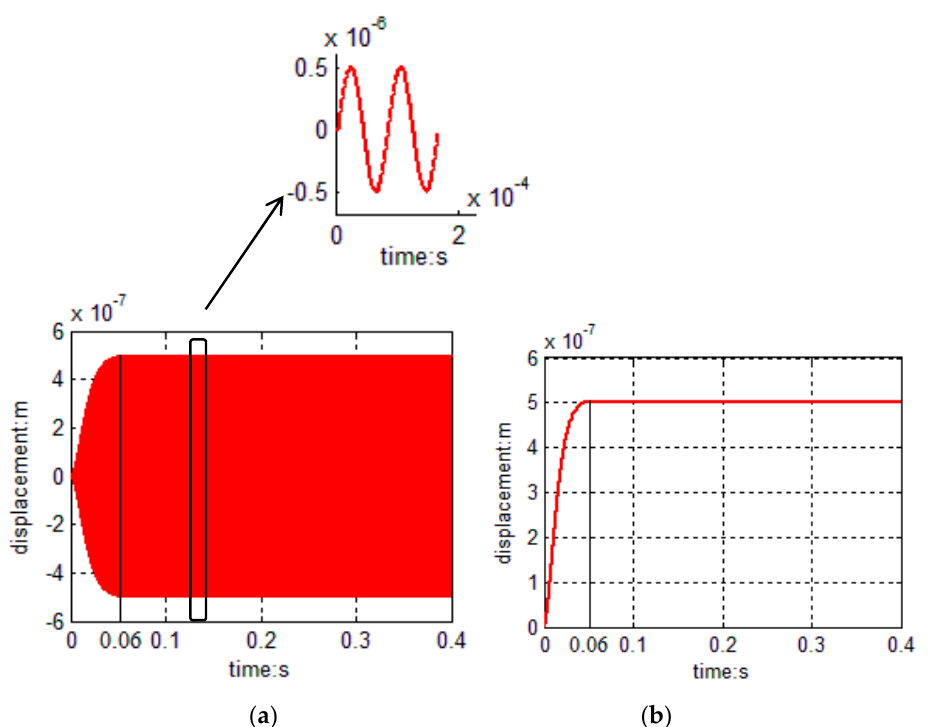
Figure 8. ( a ) Step response of AGC original model and ( b ) step response of the AGC linearized model.